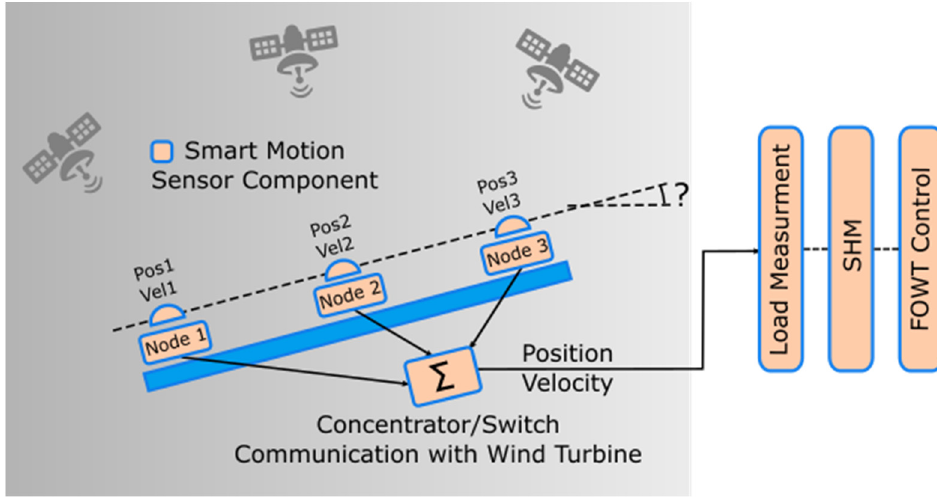
Figure 1. Mooring sense smart sensor system block.